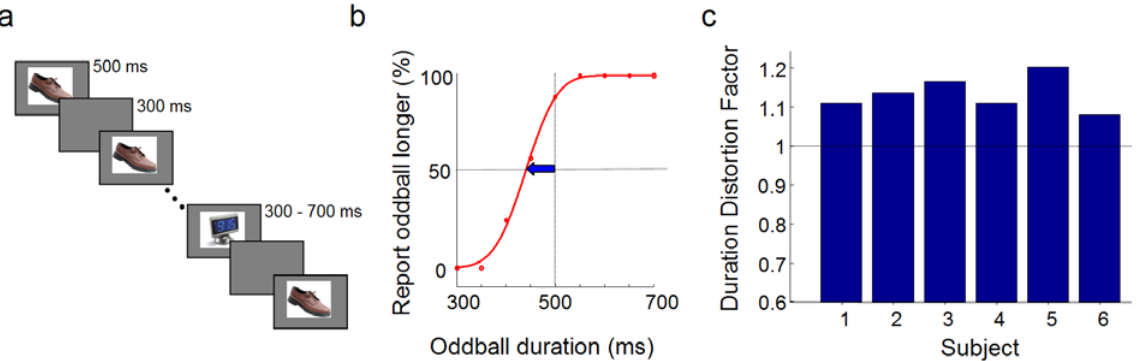
Figure 1. Duration distortion using pictures of everyday objects . (a) Schematic of experiment. Participants reported whether the oddball object embedded at a random position in a stream appeared longer or shorter than the standard (b) Representative data from one participant. The point of subjective equivalence was taken as the 50% point of the psychometric function. (c) The Duration Distortion factor (DDF) is the ratio of the standard duration to the PSE of the oddball for 6 participants.